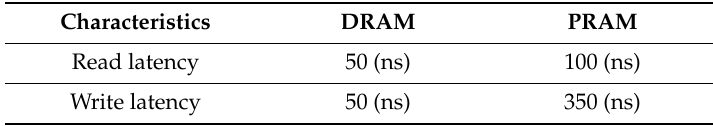
Table 1. DRAM (dynamic random access memory) and NVRAM (nonvolatile random access memory)